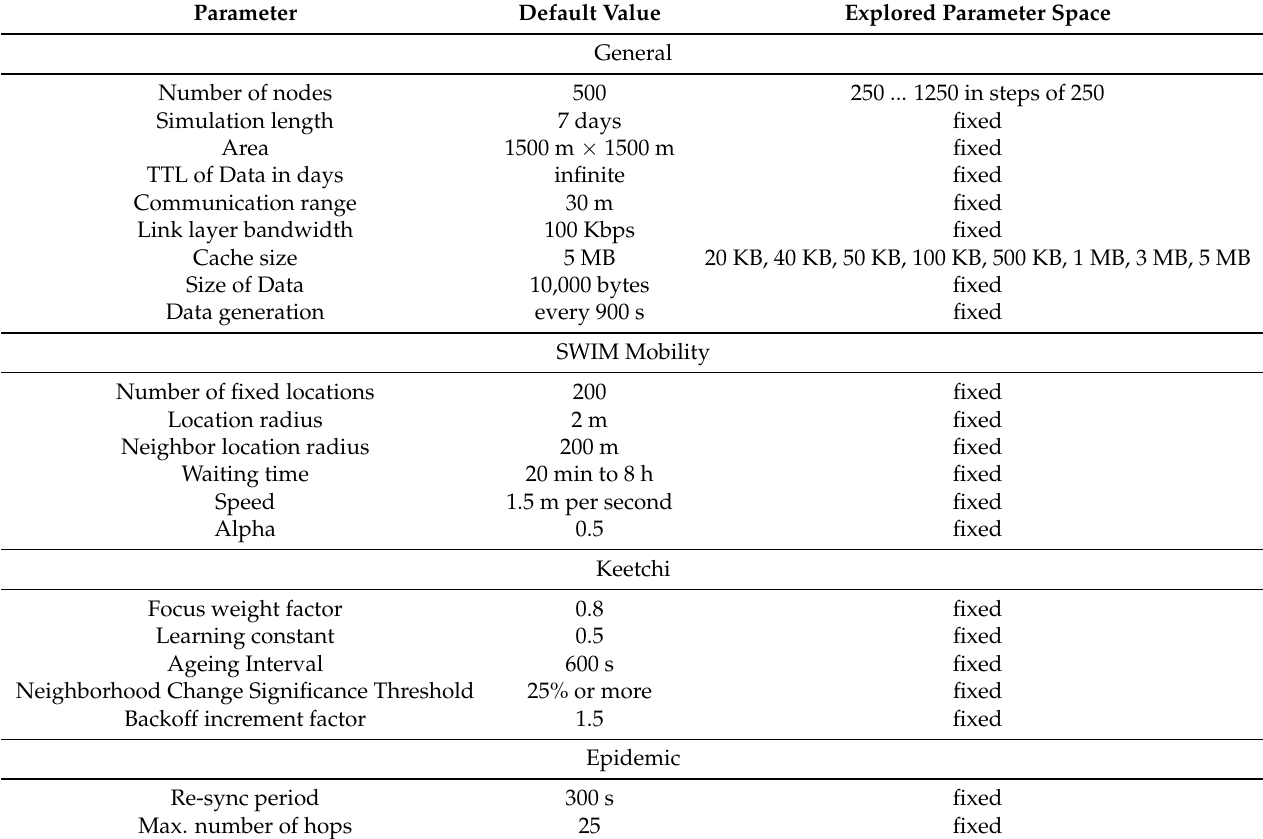
Table 2. Jodel-like reference scenario for the university campus of